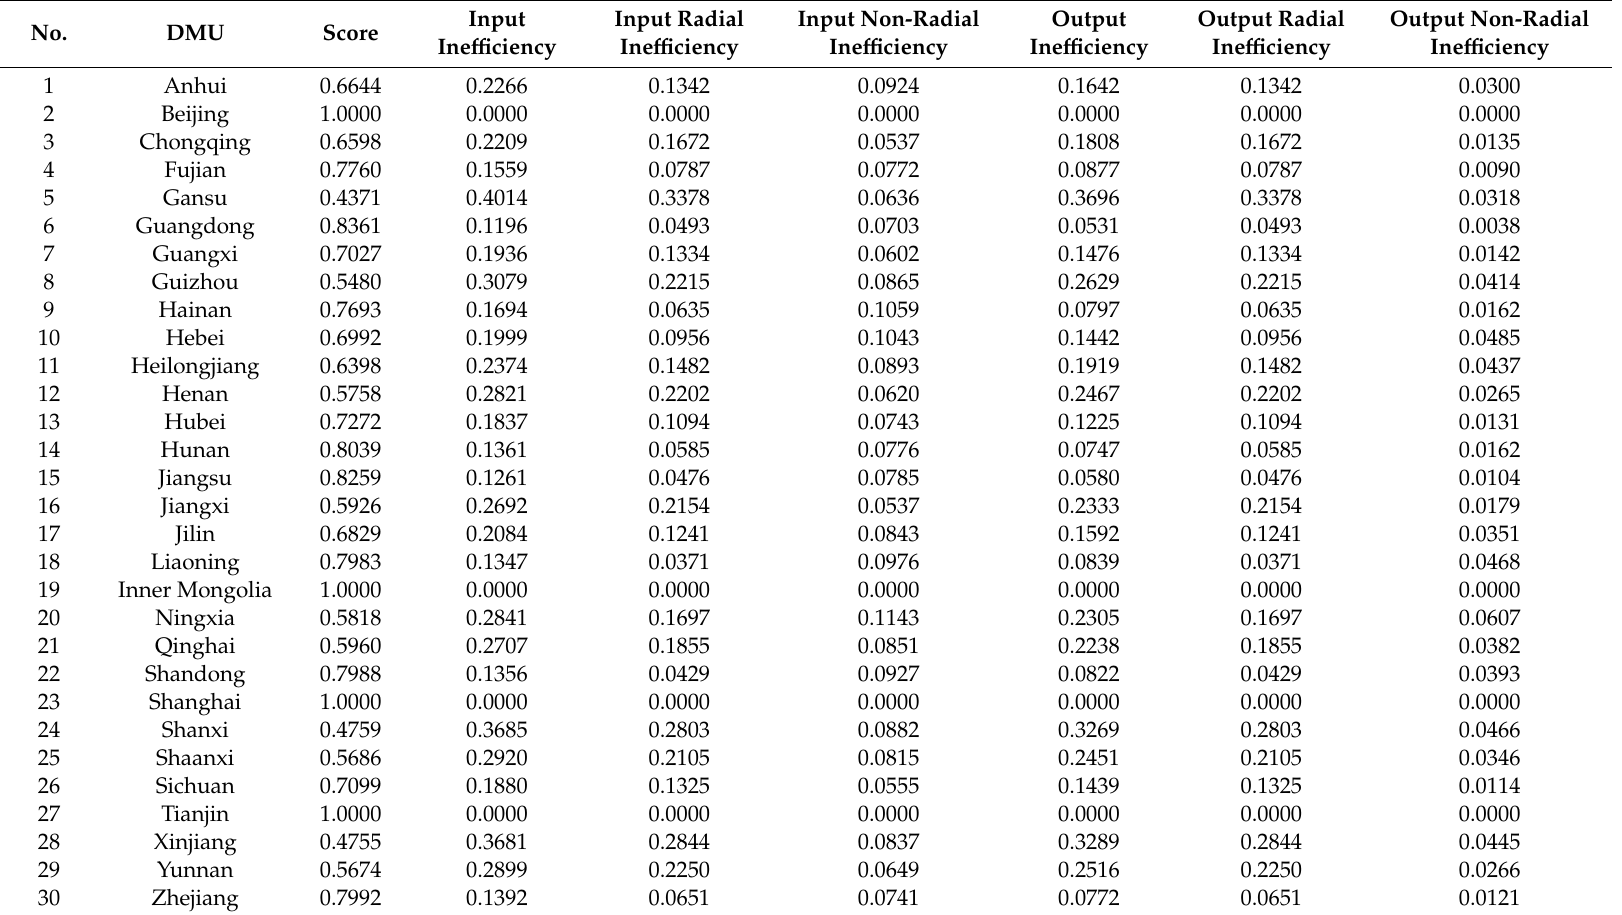
Table 6. 2015 input and output indicator radial and non-radial ine ffi ciency